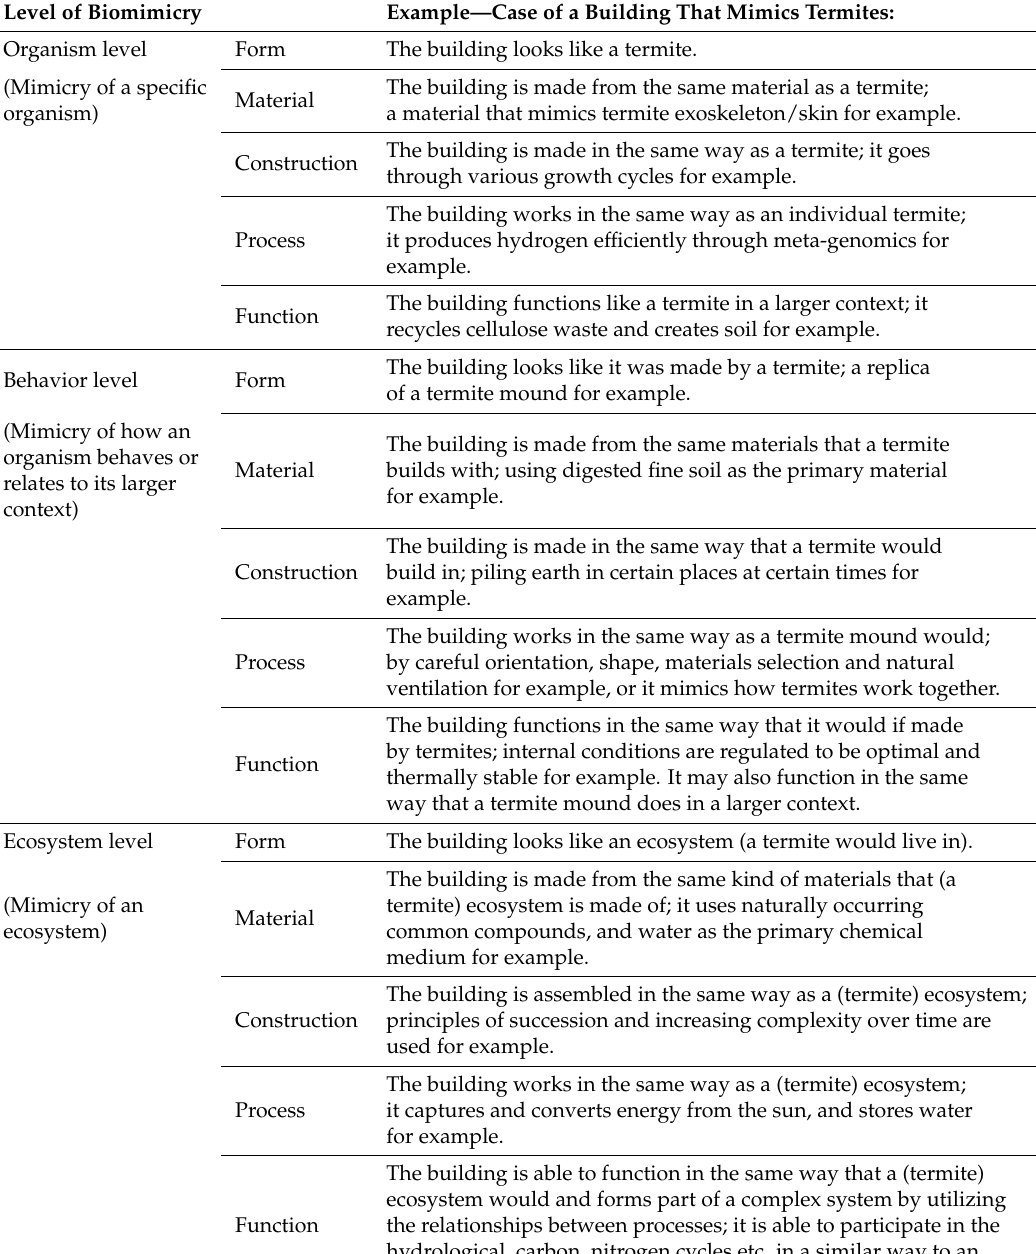
Table 1. A framework for the application of biomimicry (adapted from